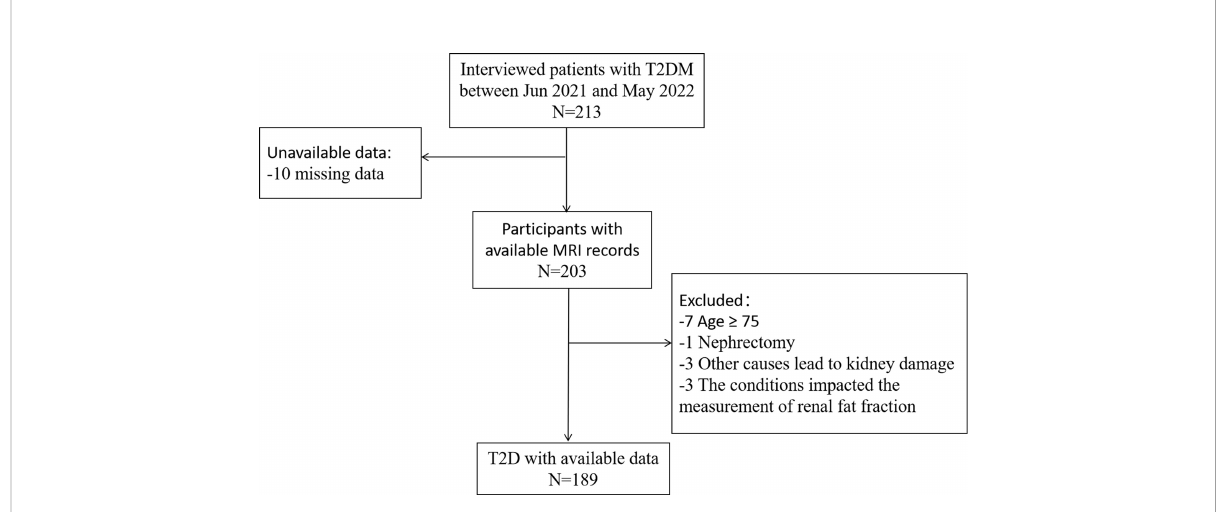
FIGURE 1 Flow chart of study population in the